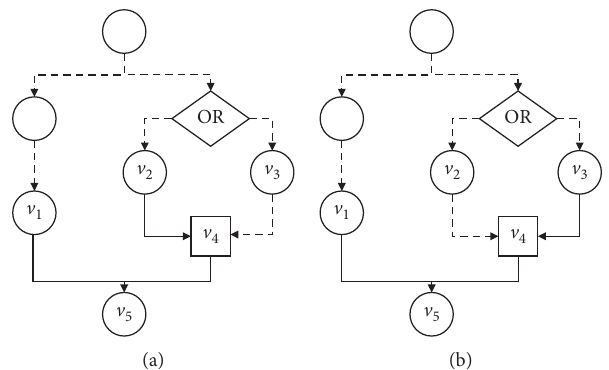
, v , v , v 􏼈 􏼉 and (b) a new 5 1 4 2